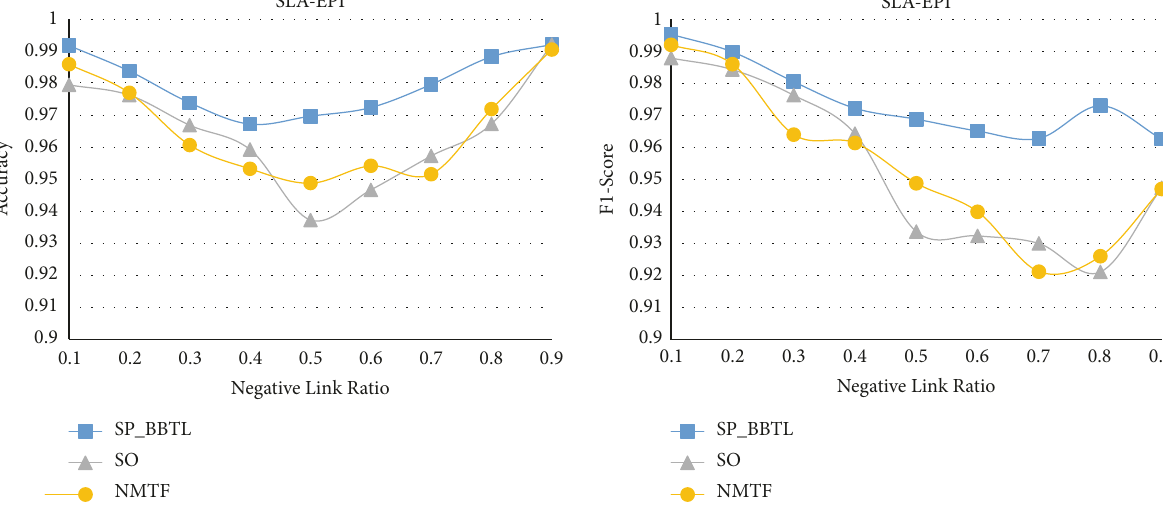
Figure 4: Sign prediction performances with the various negative link ratio.